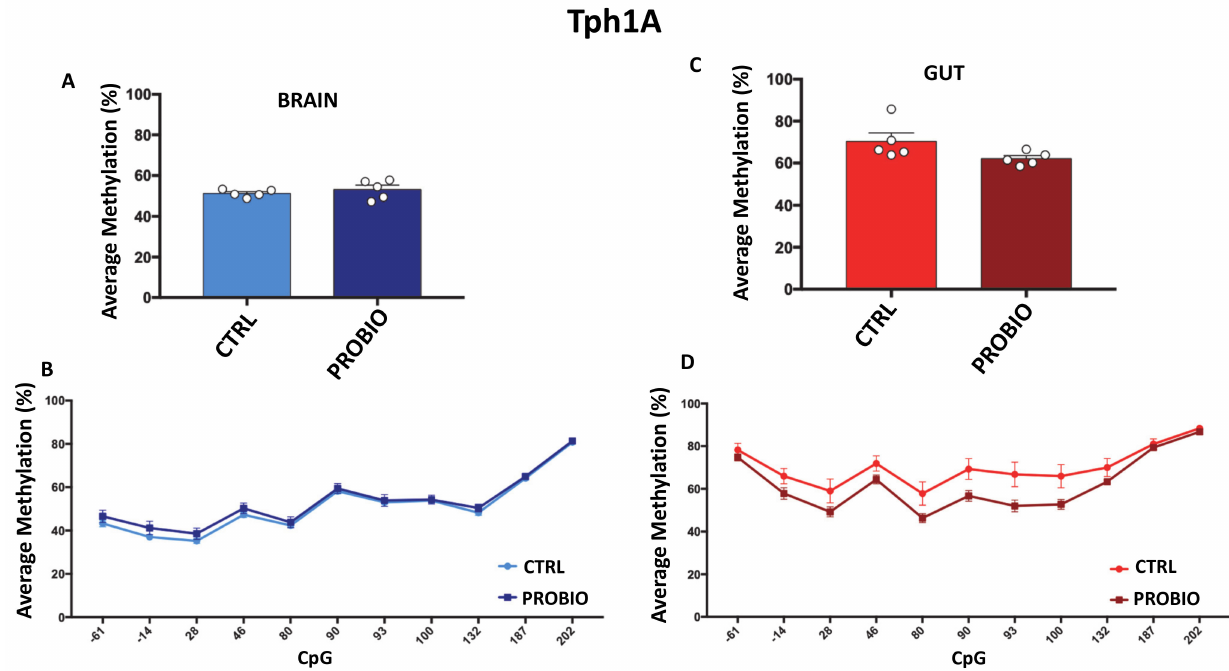
Figure 4. Comparison of Tph1A DNA methylation between CTRL and PROBIO groups in gut and brain. ( A ) Average methylation (%) of Tph1A in the brain of untreated (CTRL) and probiotic-treated (PROBIO) Zebrafishes . Statistical analysis was performed using Student t -test. ( B ) Methylation level (%) at Tph1A single-CpG sites was shown for the brain of CTRL and PROBIO groups. ( C ) Tph1A average methylation (%) in the gut of untreated (CTRL) and probiotic-treated (PROBIO) Zebrafishes . Statistical analysis was performed using Student t -test. ( D ) Single-CpG methylation (%) at the Tph1A promoter in the gut of the CTRL and PROBIO groups. Statistical analyses were performed using one-way ANOVA followed by Tukey’s multiple comparison post-hoc